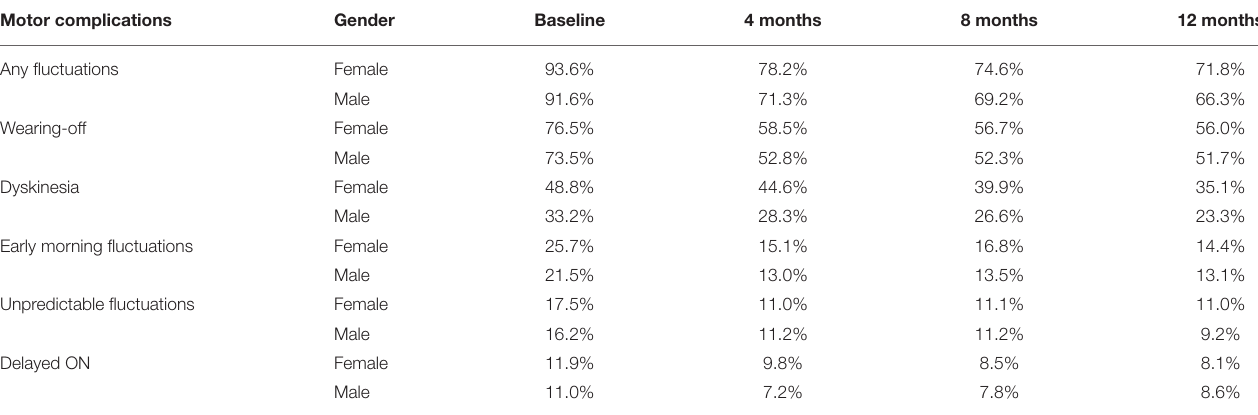
TABLE 5 | Prevalence of fluctuations and dyskinesia according to gender at the start of treatment with safinamide and during the follow-up. Motor